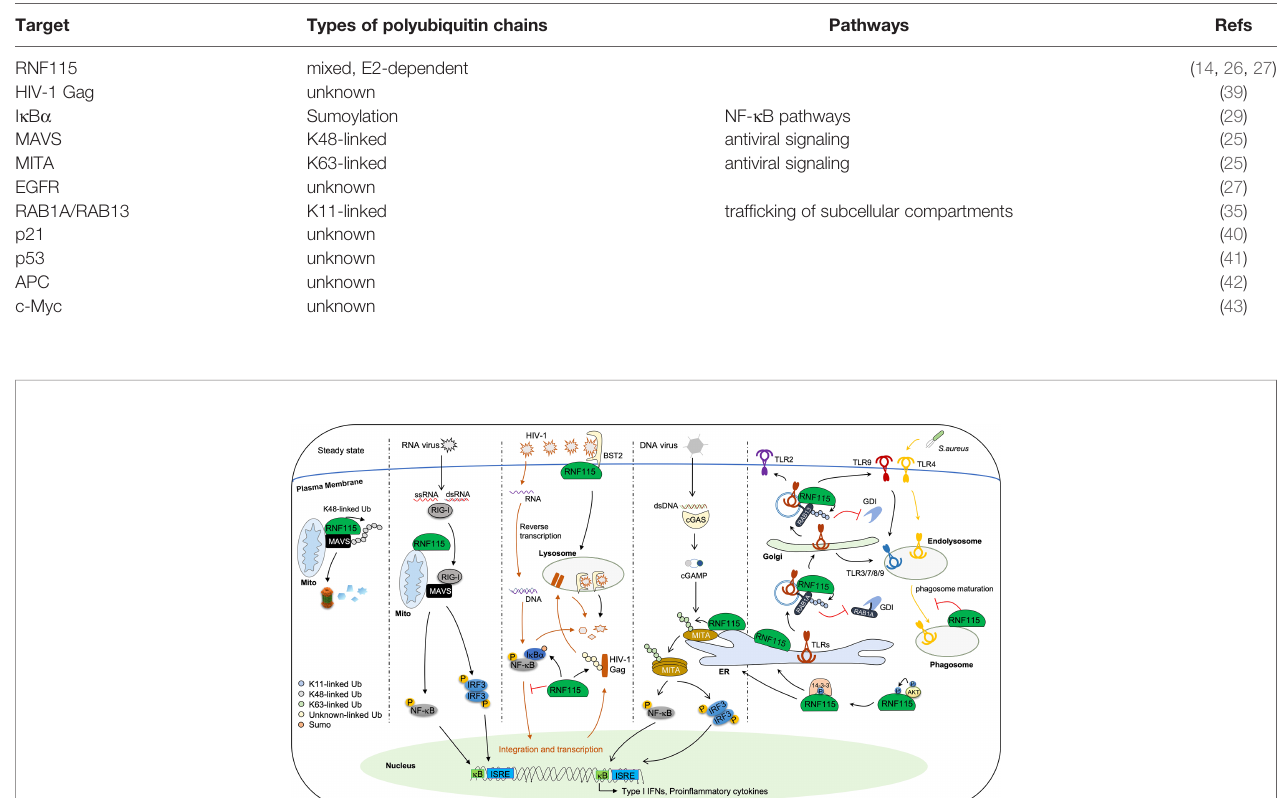
TABLE 1 | Substrates of